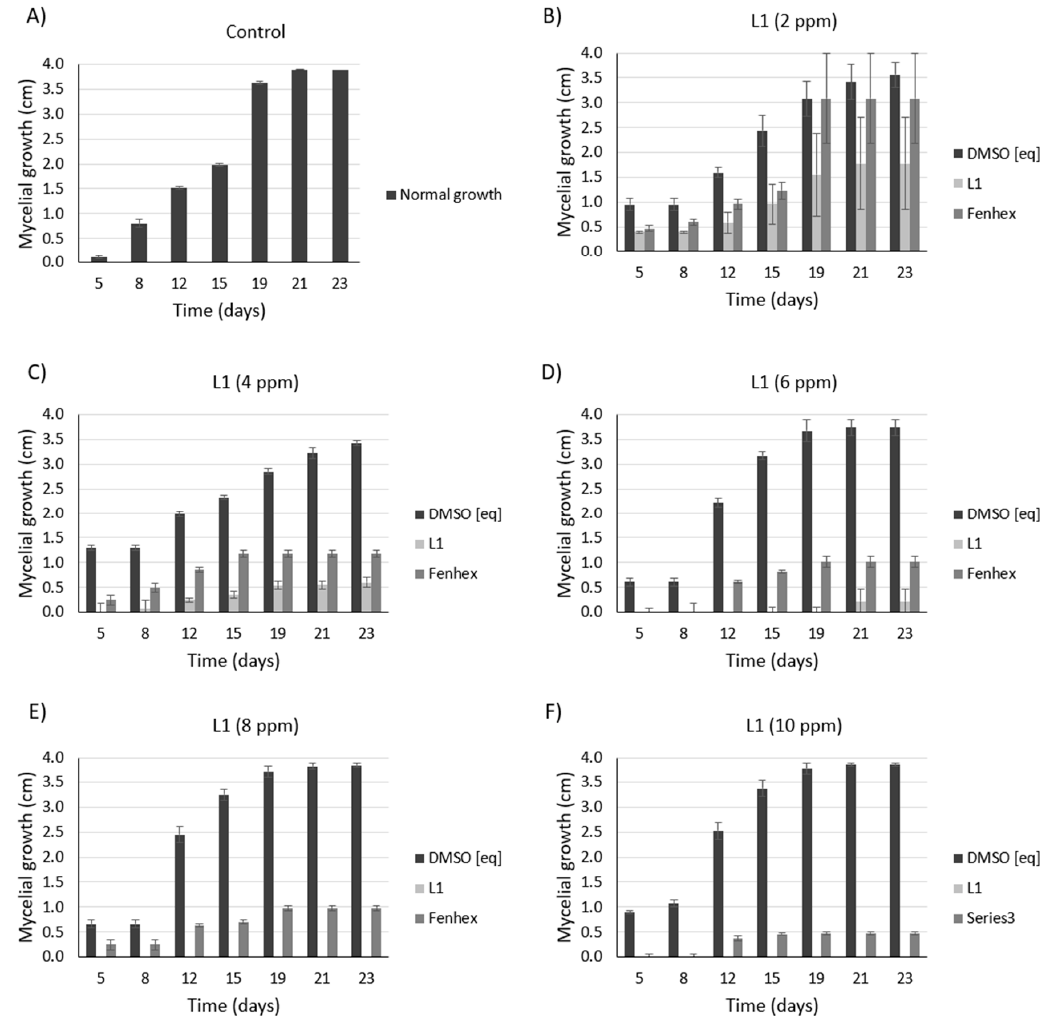
Figure 7. Antifungal effect against Botrytis cinerea A1 (at 26 °C) exerted by L1 in a dose-dependent manner. Inhibition of mycelial growth (by measuring the colony diameter) was observed in the presence of L1 ( A : 0 ppm, B : 2 ppm, C : 4 ppm, D : 6 ppm, E : 8 ppm, F : 10 ppm) and compared with the commercial fungicide fenhexamid ( A : 0 ppm, B : 2 ppm, C : 4 ppm, D : 6 ppm, E : 8 ppm, F : 10 ppm). Since both L1 and fenhexamid stock were dissolved in DMSO (vehicle), DMSO alone was also tested, adding the same concentration used with either L1 or fenhexamid in each case ( A : 0% v/v , B : 0.015% v/v , C : 0.030% v/v , D : 0.045% v/v , E : 0.060% v/v , F : 0.075% v/v ) (DMSO [eq]). In all cases, the experiments were performed in biological triplicate.